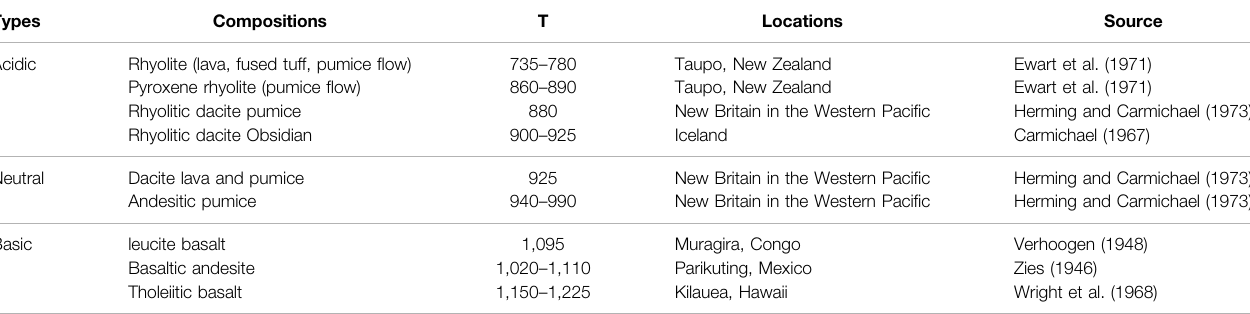
TABLE 6 | Temperature of the ejected lava in the different volcanic areas ( °